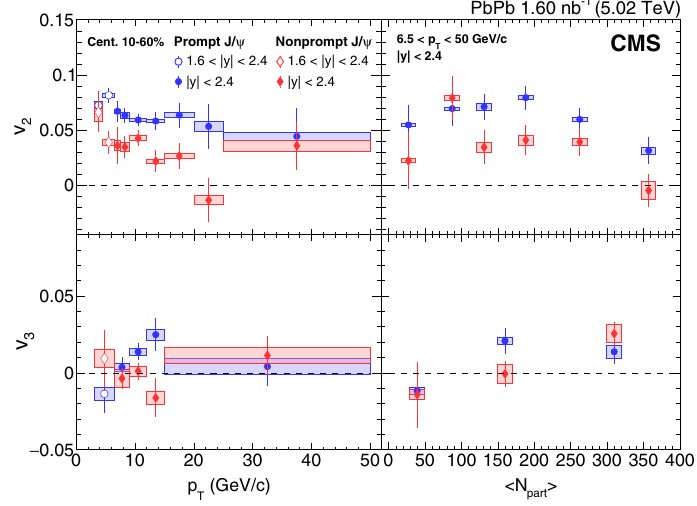
N part (right) for prompt ⟨ ⟩ y < 2.4 and y < 2.4, respectively (left panel). The results for p T bins | | | | y < 2.4. The vertical bars denote the statistical | |